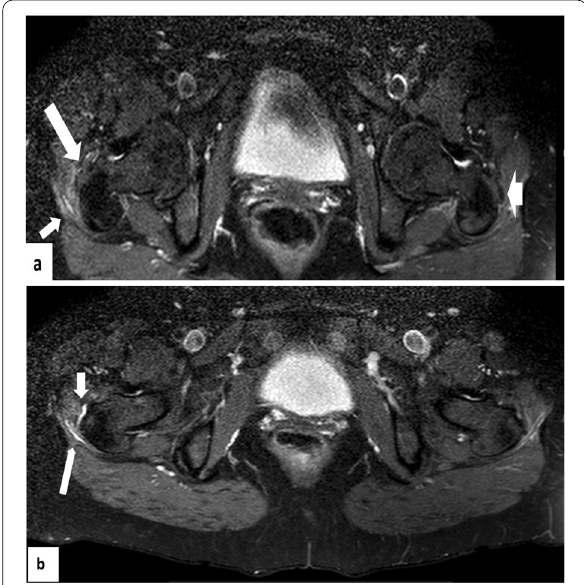
Fig.3 a Axial PDFS of 57 years old female: right GTPS; fluid signal is seen superficial to the right gluteus minimus tendon within the greater trochanteric bursa (short white arrow). Partial thickness tear of the insertional fibers of the gluteus minimus (long white arrow). Note intact insertion of the left gluteus minimus tendon (white arrowhead). b Axial PDFS of the same patient at a higher level: fluid signal is noted with the sub-gluteus minimus bursa (short white arrow) as well as fluid signal is seen within the sub-gluteus maximus bursa i.e., greater trochanteric bursa (long white